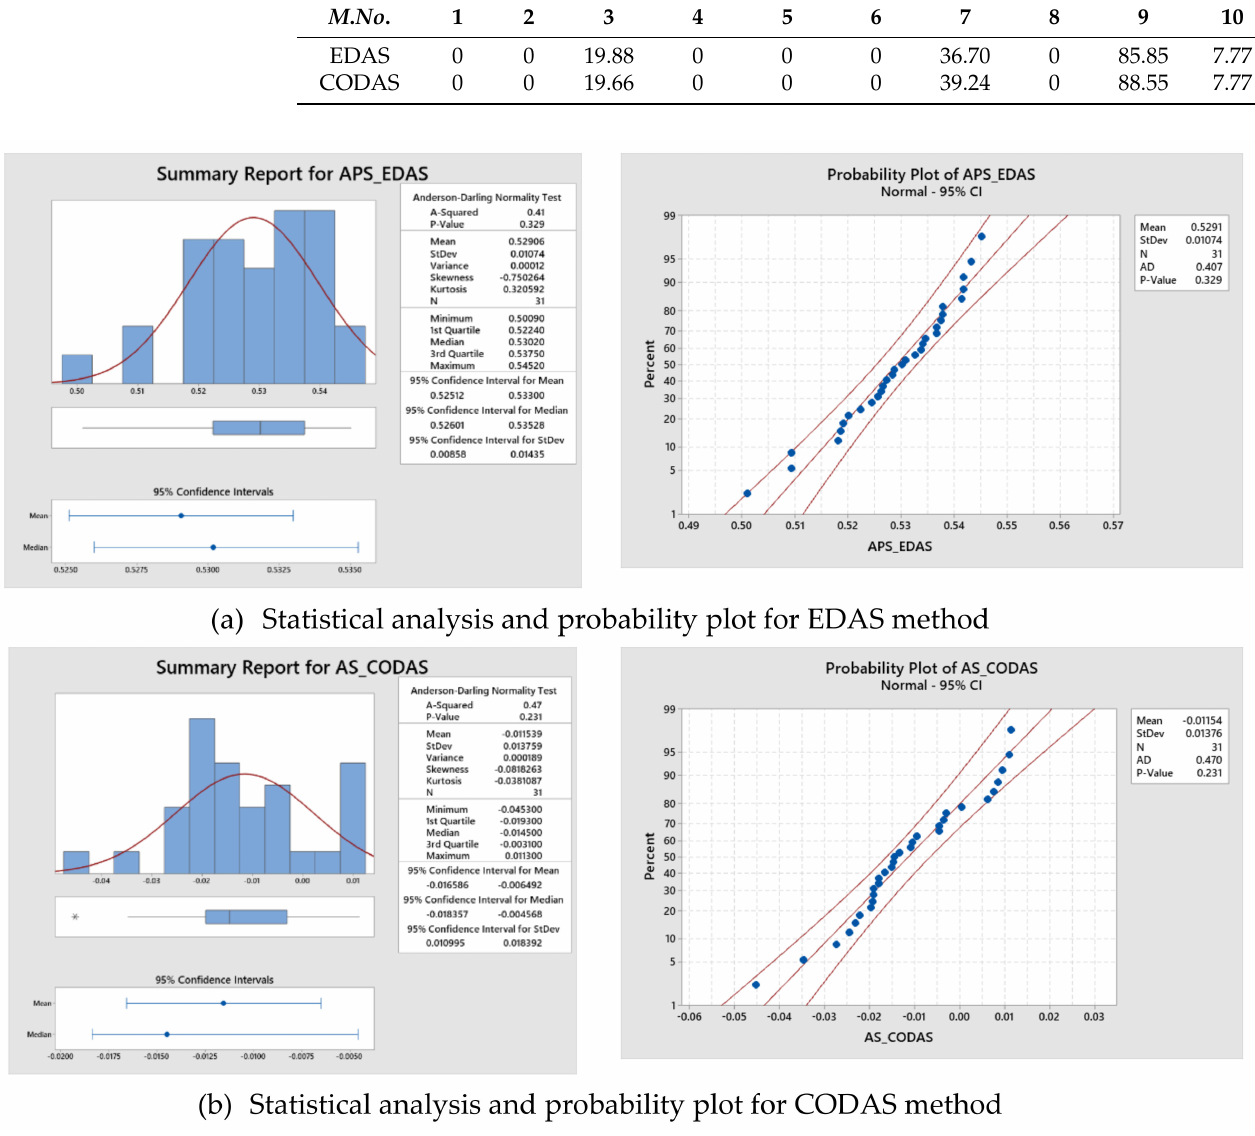
Figure 11. Statistical analysis and probability plot for EDAS and CODAS